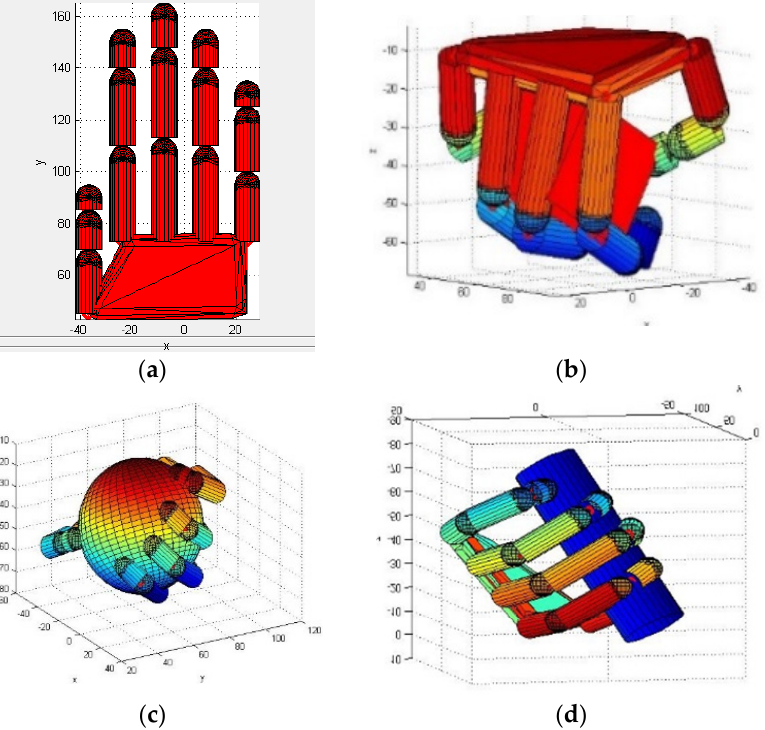
Figure 11. Simulated manipulator and grasping actions for different objects: ( a ) under-actuated hand manipulator, ( b ) grasping of a square object, ( c ) grasping of a spherical object and ( d ) grasping of a rod-shaped object.